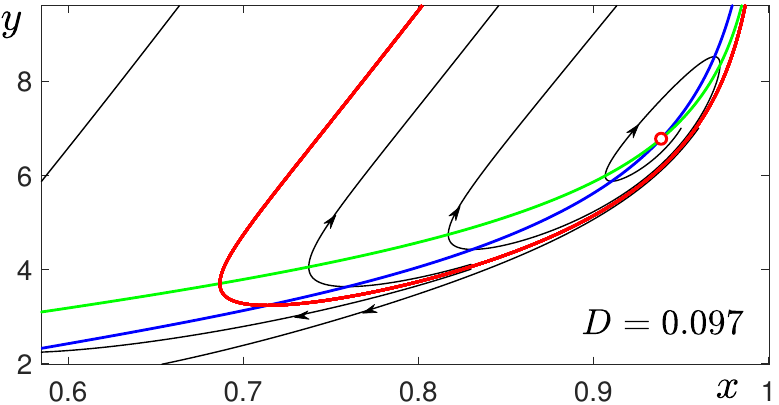
Figure 5. Local instability of the Canard cycle of system (1) with D = 0.097: deterministic phase trajectories (black) near the lower part of the Canard cycle (red), nullcline ˙ x = 0 (green), nullcline ˙ y = 0 (blue), and the unstable equilibrium (empty